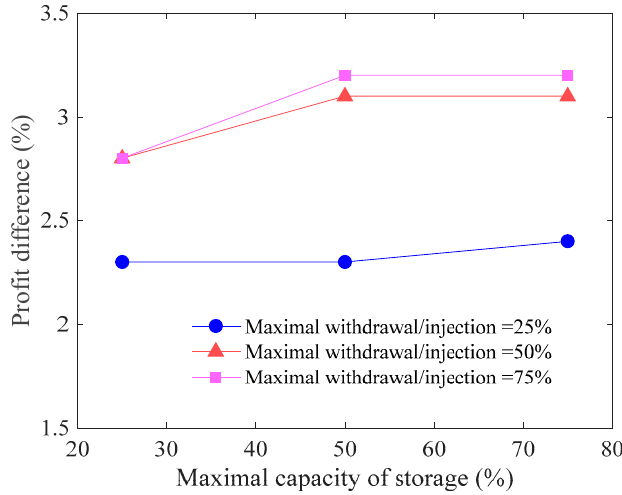
Figure 18. Sensitivity analysis: gas storage size.